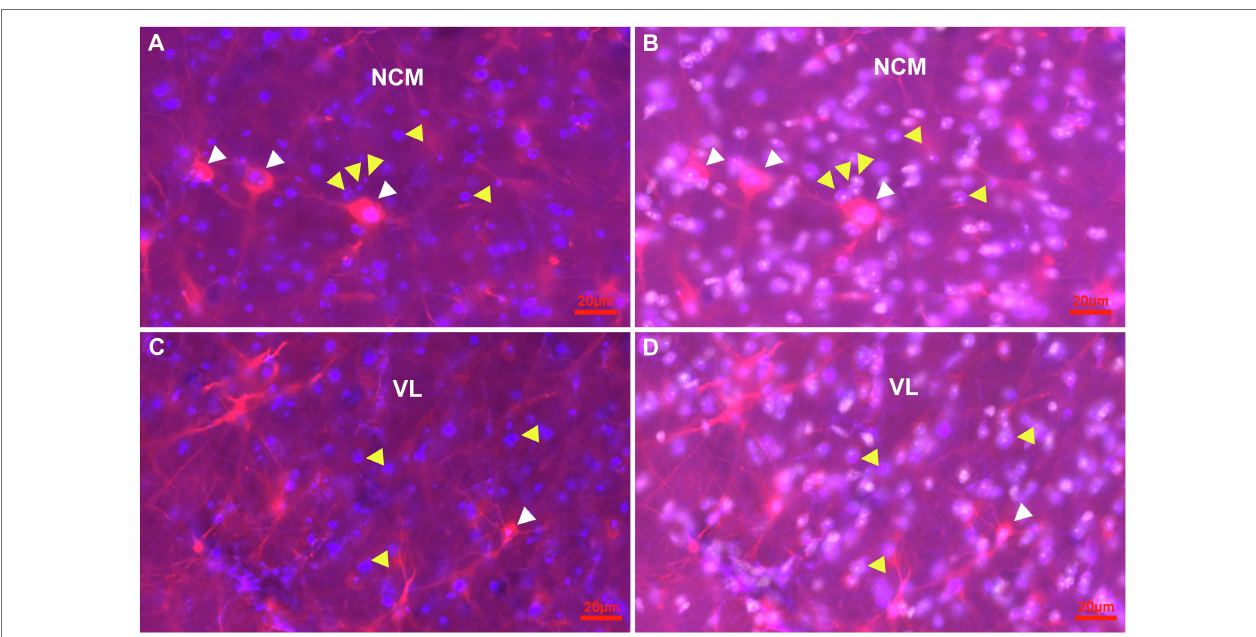
FIGURE 7 | Representative pictures of the parenchym of the NCM and the VL of the HF with cells immunostained for Ki67 and DCX in combination with Hoechst at atlas level A4.50. (A,B) Detail of Ki67 + (blue) cells (yellow arrowheads) and DCX+(red) cells (white arrowheads) in the NCM. A stage 3 ovoidal DCX+/Ki67+ double labelled cell (pink) is shown (most left), while the other two larger DCX+/Ki67+ double labelled cells show pronounced fibres akin like multipolar stage 4 cells (A) . Hoechst staining (white) revealed that Ki67 is located in the nuclei of cells (B) . (C,D) Detail of Ki67 + (blue) cells (yellow arrowheads) and DCX+(red) cells (white arrowheads) in the VL region of the HF. A typical multipolar DCX+/Ki67+ double labelled cell (pink) of stage 4 of the VL region (white arrowhead). Hoechst staining (white) showed that Ki67+ is expressed in the nuclei (D)